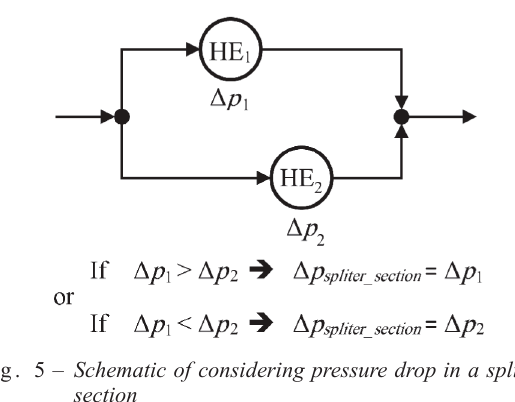
Fig. 5 – Schematic of considering pressure drop in a splitter